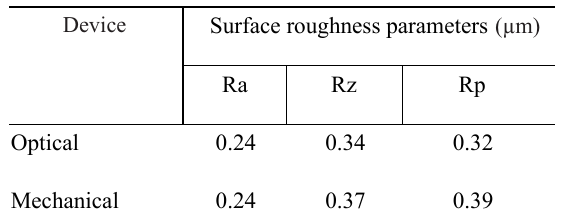
Table 2. C10 alumina ceramic balls’ surface roughness